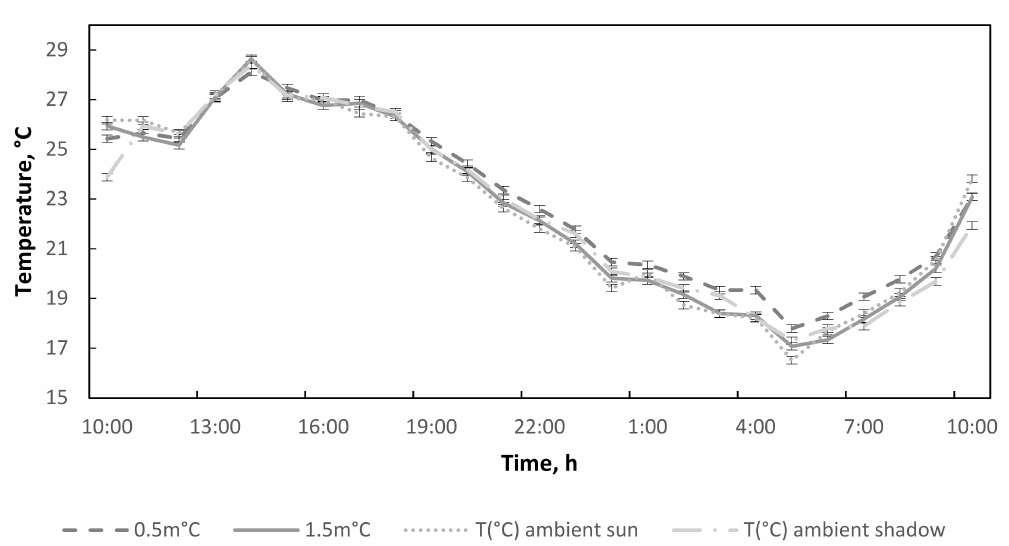
Figure 8. Data from Table 3.